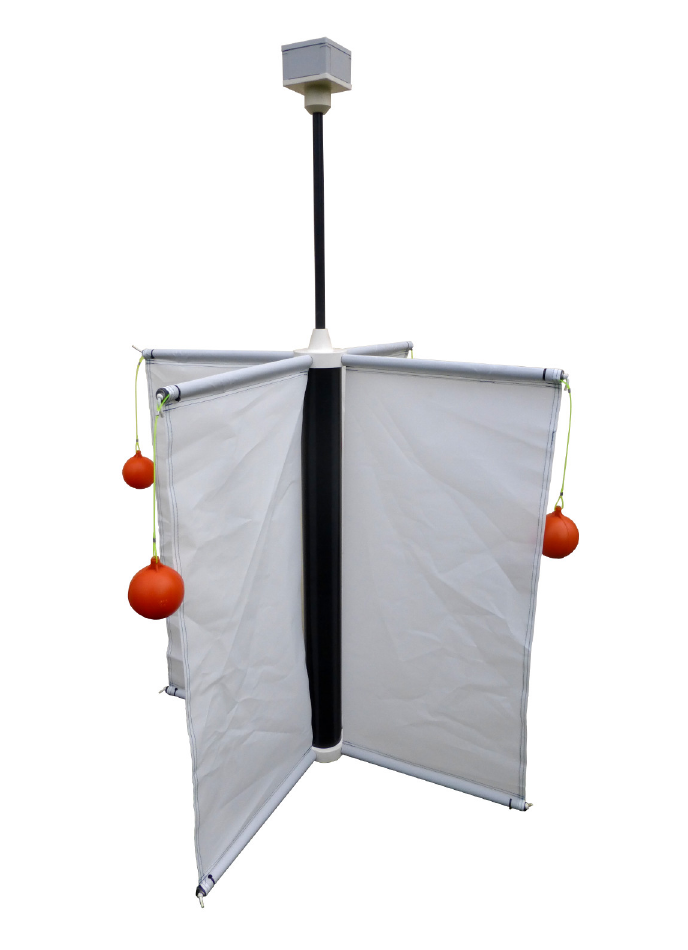
Figure 1. Low-cost CODE drifter equipped with LoRa transceiver in the